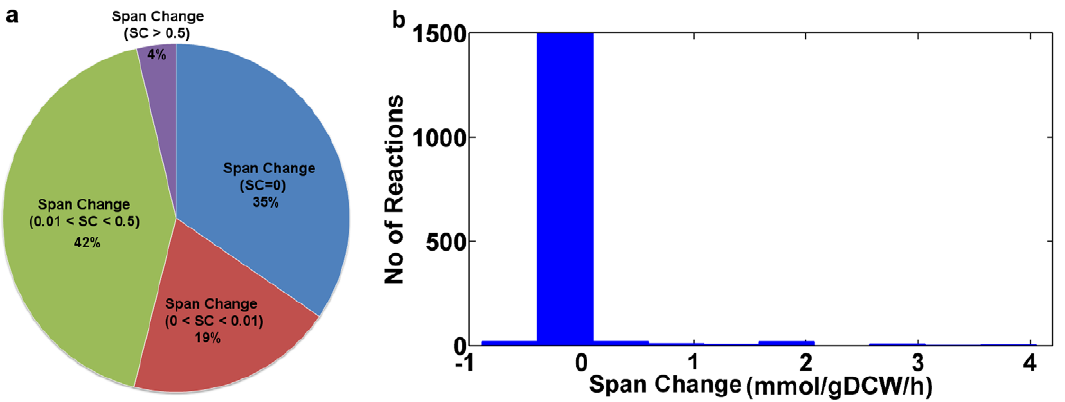
Figure 4. The flux span is obtained using maximum and minimum allowable flux values for all reactions. The difference of flux span between engineered cofactor imbalanced (ECI) and engineered cofactor balanced (ECB) models is given by SC=Span ECI -Span ECB . The relative change in flux span between ECI and ECB models are (a) grouped into SC . 0.5, 0.01 , SC , 0.5, 0.0 , SC , 0.01 and SC=0 with 4%, 42%, 19% and 35% of total reactions respectively, in the entire metabolic network, and (b) plotted as histogram with span change on x-axis and number of reactions on the y-axis.